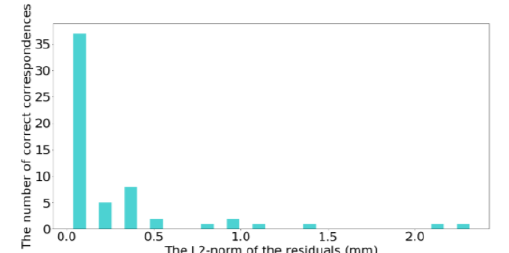
Figure 10. L2-norms of the residuals for correct corresponding keypoints.